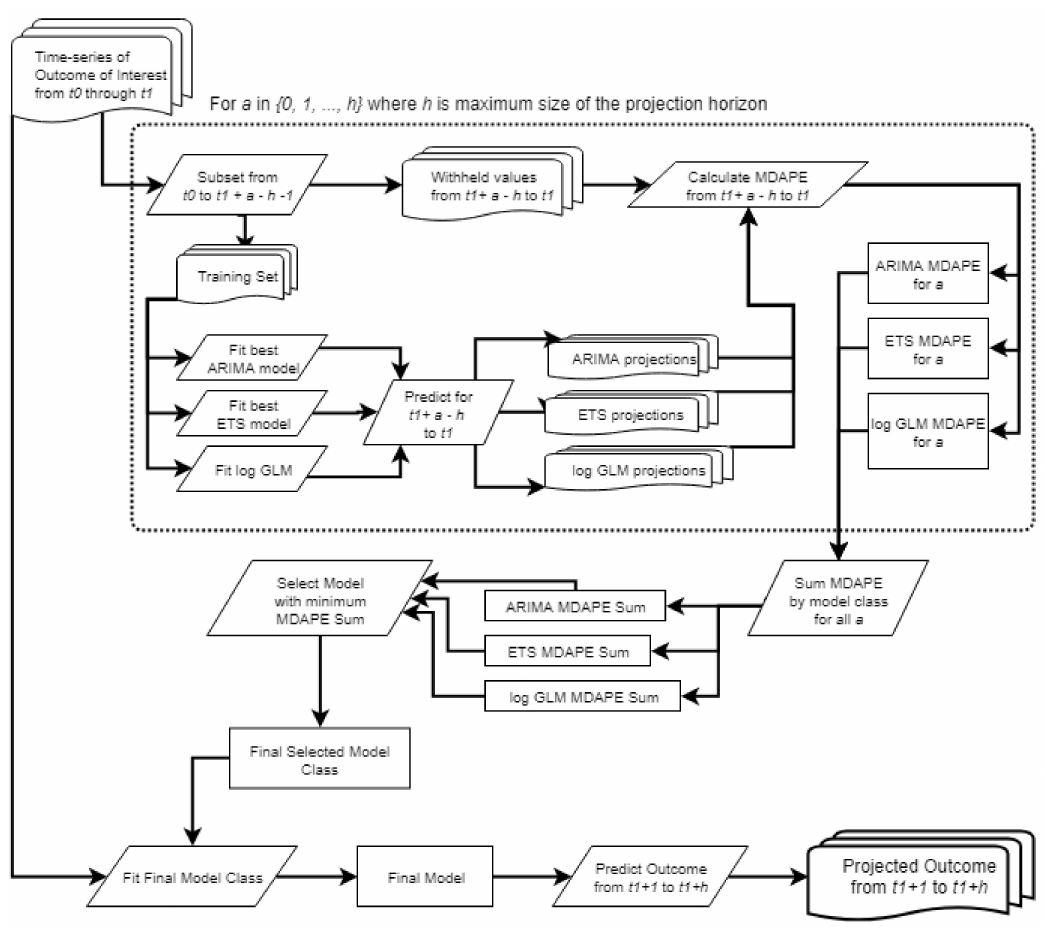
Figure A2. Full process diagram of the “Subnational Temporal Model Fitting and Prediction Procedure” referenced in Appendix A, Figure A1. Readers are directed to the main text for acronym references and details on the rolling origin framework. Table A1. Table of time specific, or assumed temporally invariant, covariates used in the modelling of the population surfaces following the procedure from Stevens et al.